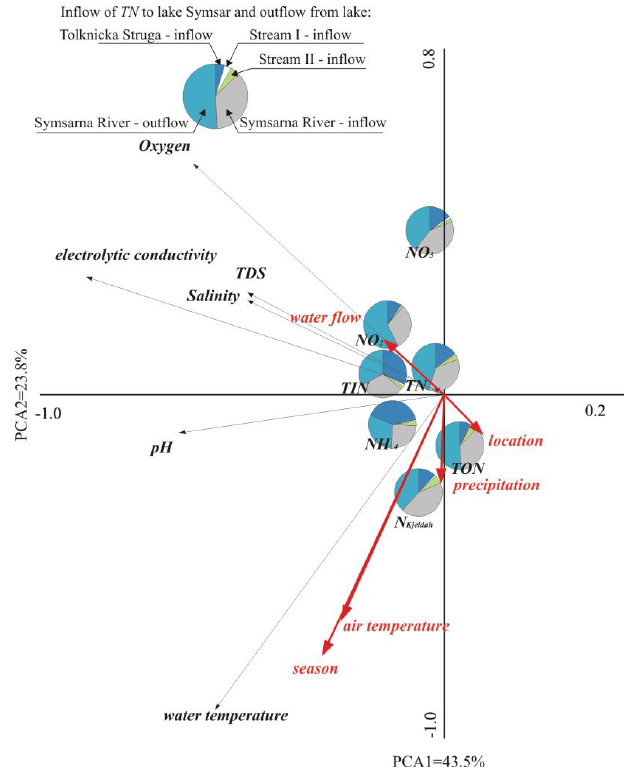
Figure 4. Ordination diagram of the principal component analysis (PCA) to identify the impacts of environmental factors on the nutrient content and physical parameters. The pie chart denotes the share of different forms of nitrogen according to the given factors.